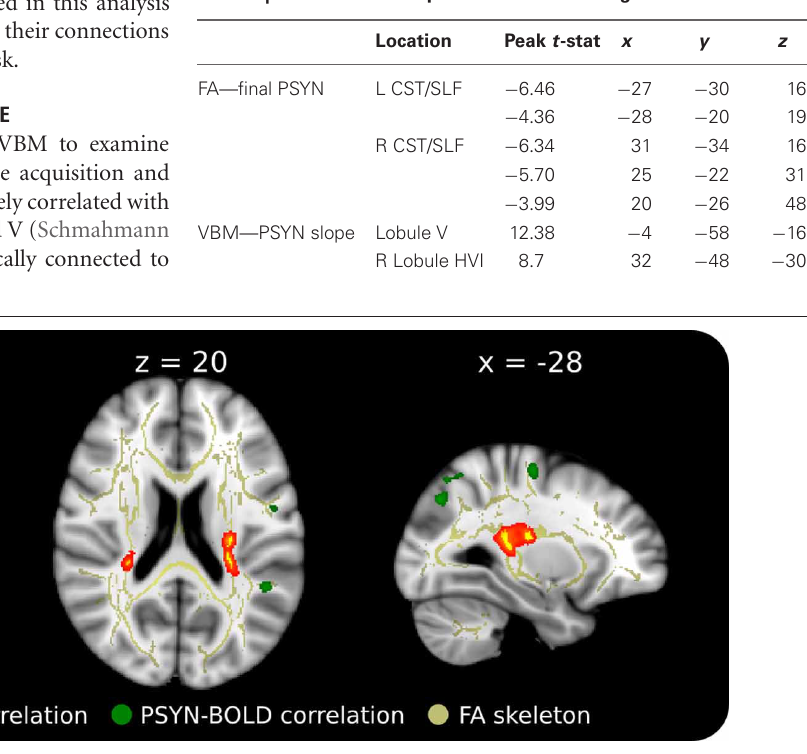
FIGURE 2 | Relationship between final synchronization performance and FA in WM underlying motor cortex in the context of regions functionally involved in this task. This negative correlation suggests that those with greater performance have lower FA in these regions that correspond well to areas functionally implicated in the task. Red-Yellow: correlation between FA